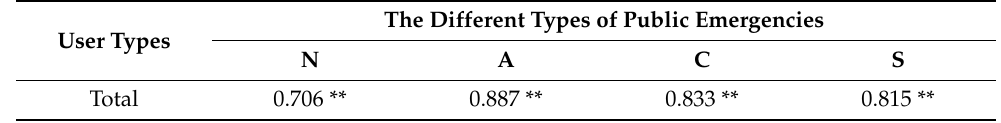
Table 7. The interrelation test of topic out-degree and emotion out-degree.